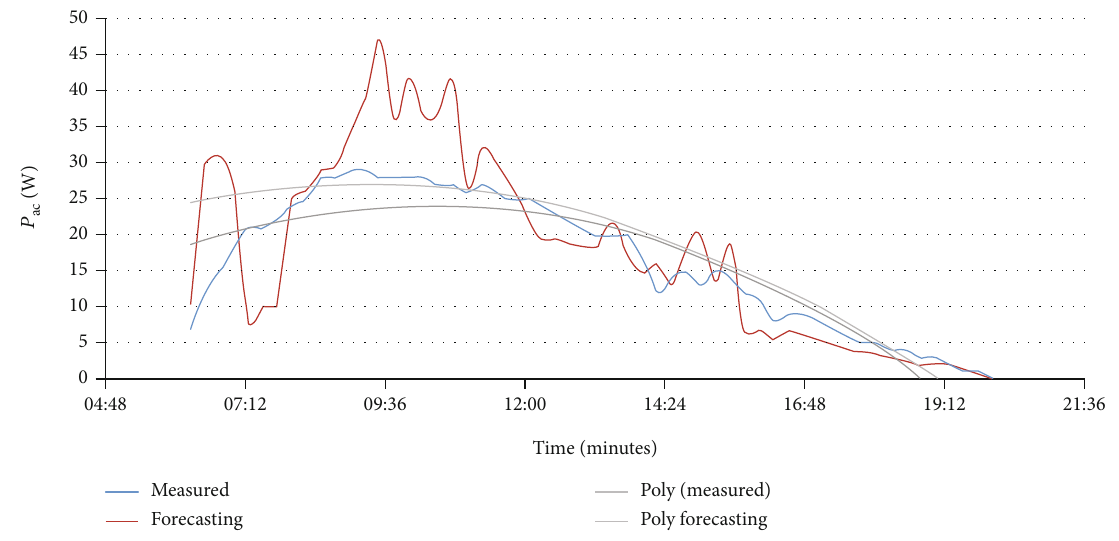
Figure 7: Comparison between measured and forecasted values of P